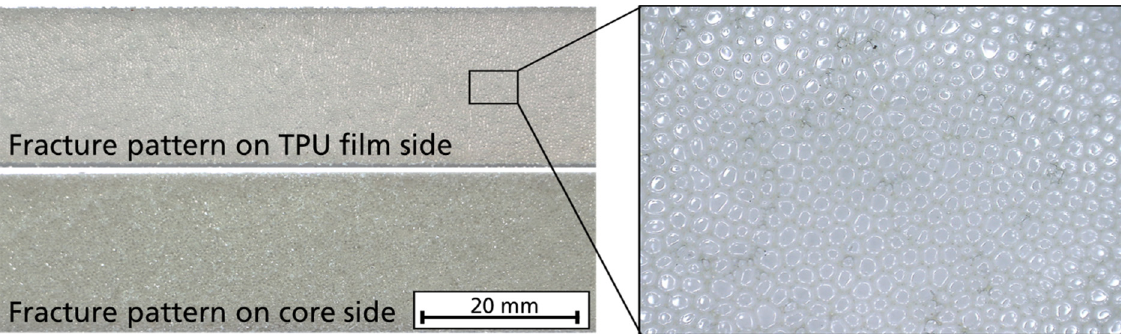
Figure 7. Fracture pattern of the cohesive failure of 3-point bending specimens.